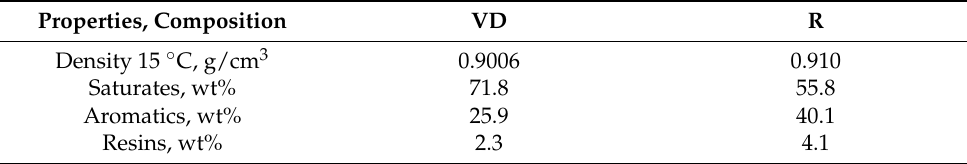
Table 1. Results of laboratory study of catalytic cracking feedstocks. Properties,